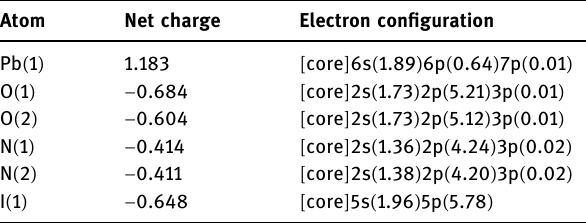
Table 2: Selected natural atomic charges and natural electron con fi guration of 1 Atom Net charge